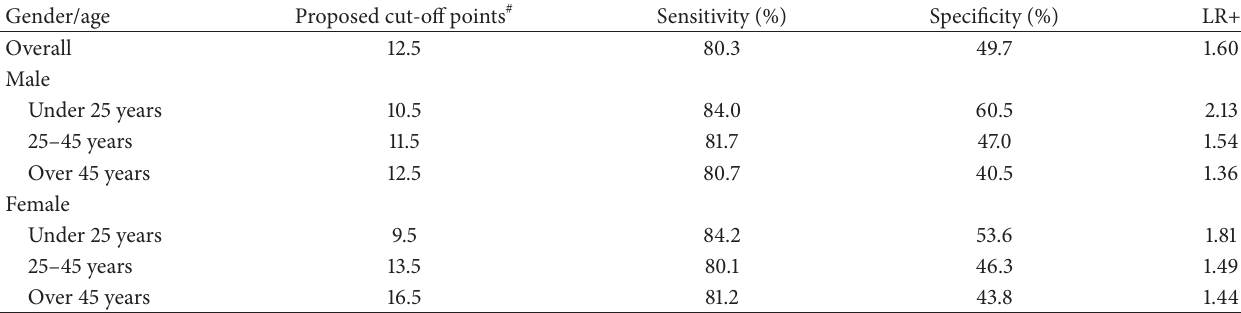
Table4:Sensitivities,specificities,andLR+oftheMcMonniesquestionnaireindifferentgender/agegroupsatnewlyproposedcut-offpoints ∗